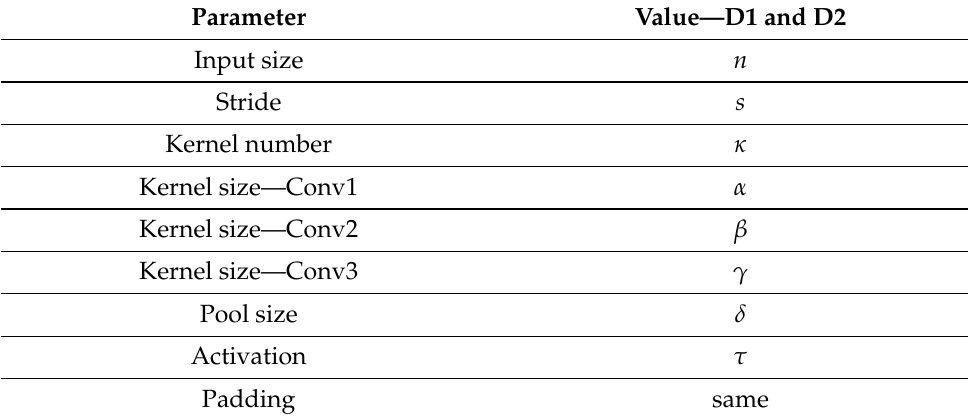
Figure 2. The Architecture of the CNN model. Table 2. Hyperparameters for the CNN layers.